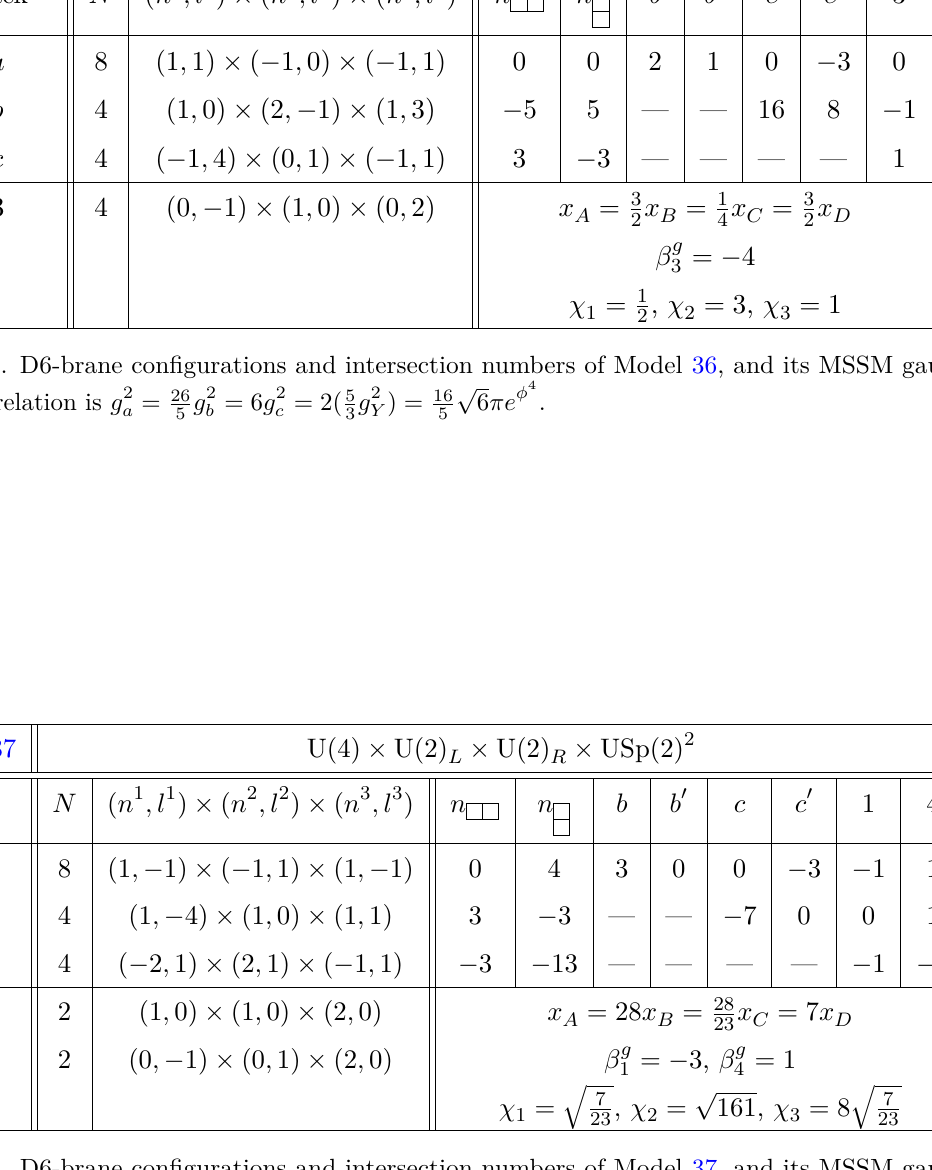
Table 37 . D6-brane configurations and intersection numbers of Model 37, and its MSSM